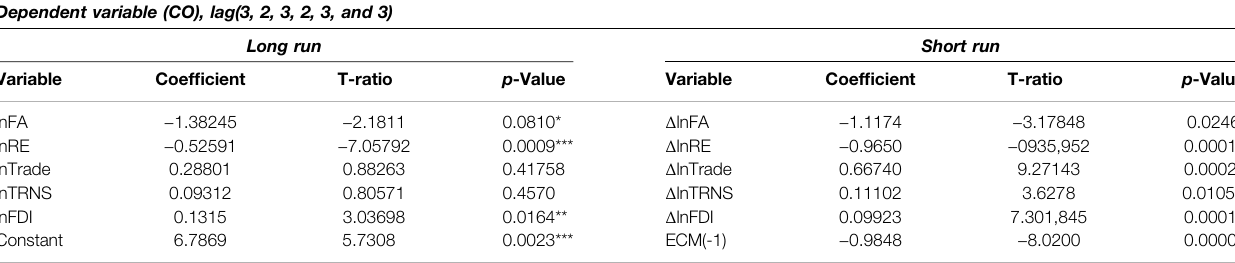
TABLE 5 | Long-run and short-run estimations. Dependent variable (CO), lag(3, 2, 3, 2, 3, and